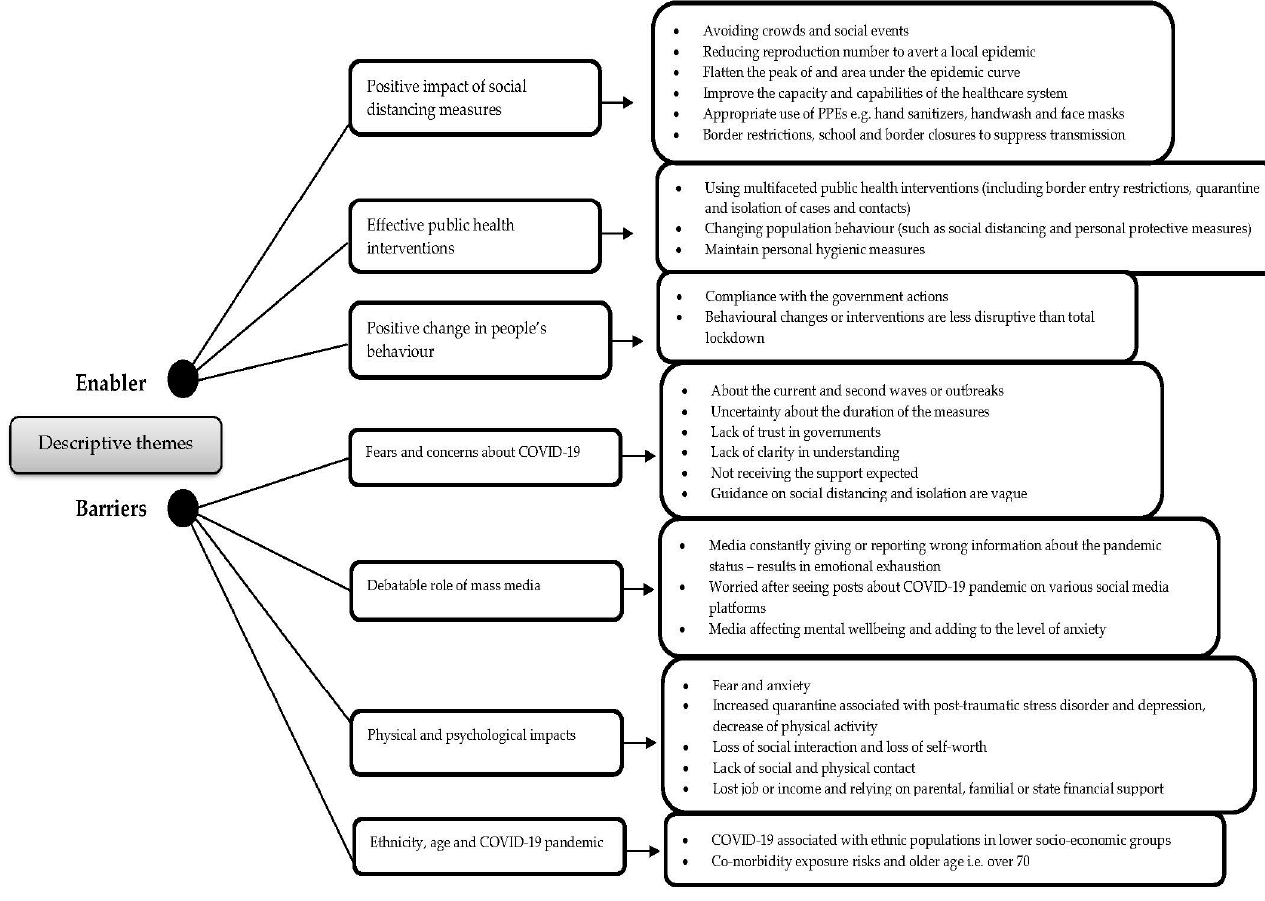
Figure 2. Themes identified across studies.